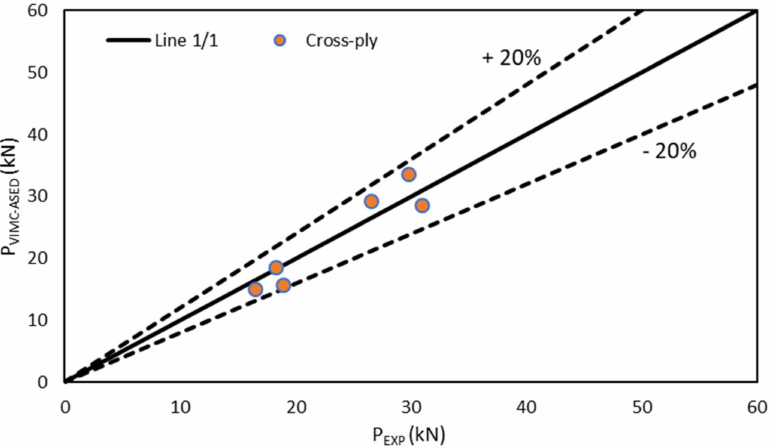
Figure 7. Comparison between the critical load prediction and experimental results in cross-ply specimens